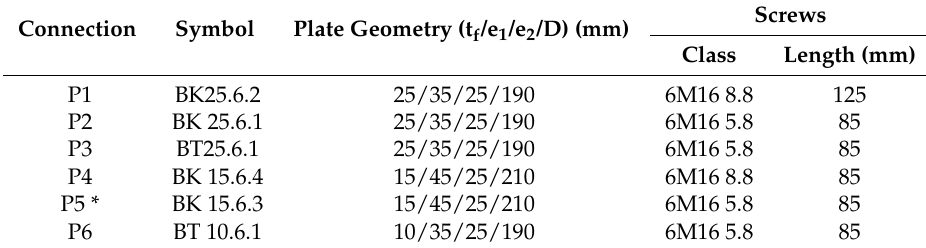
Table 1. Dimensions of the investigated flange connections.